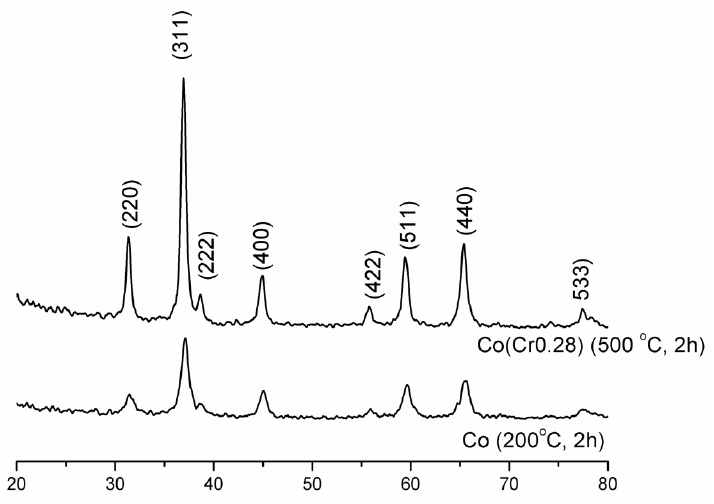
/Ar, 10°/min from 100 to 2